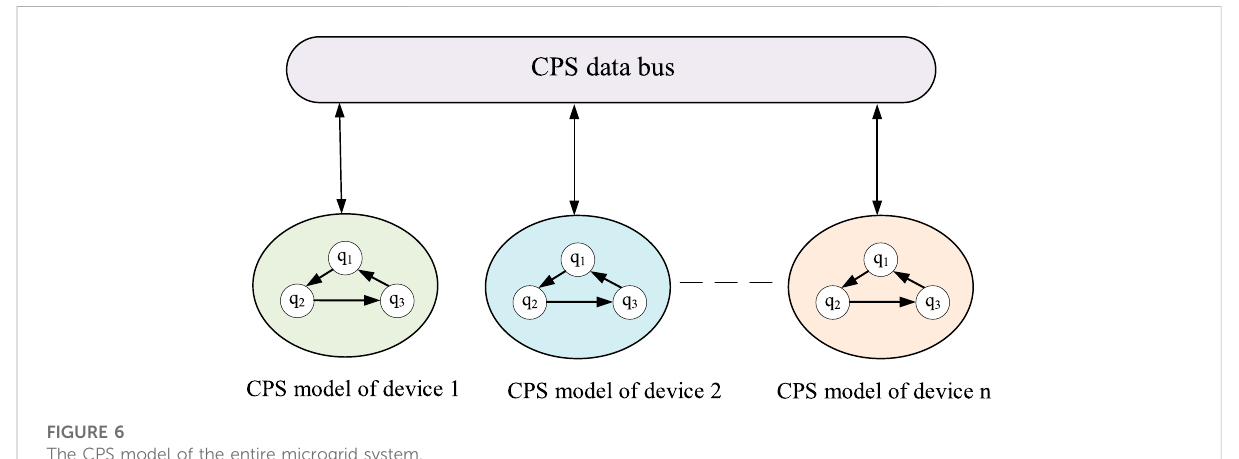
FIGURE 6 The CPS model of the entire microgrid